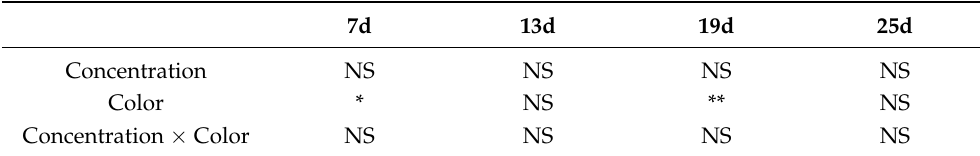
Table A1. Two-way ANOVA conducted shows the effects of concentration, color, and their interaction on the cell density of M. aeruginosa .